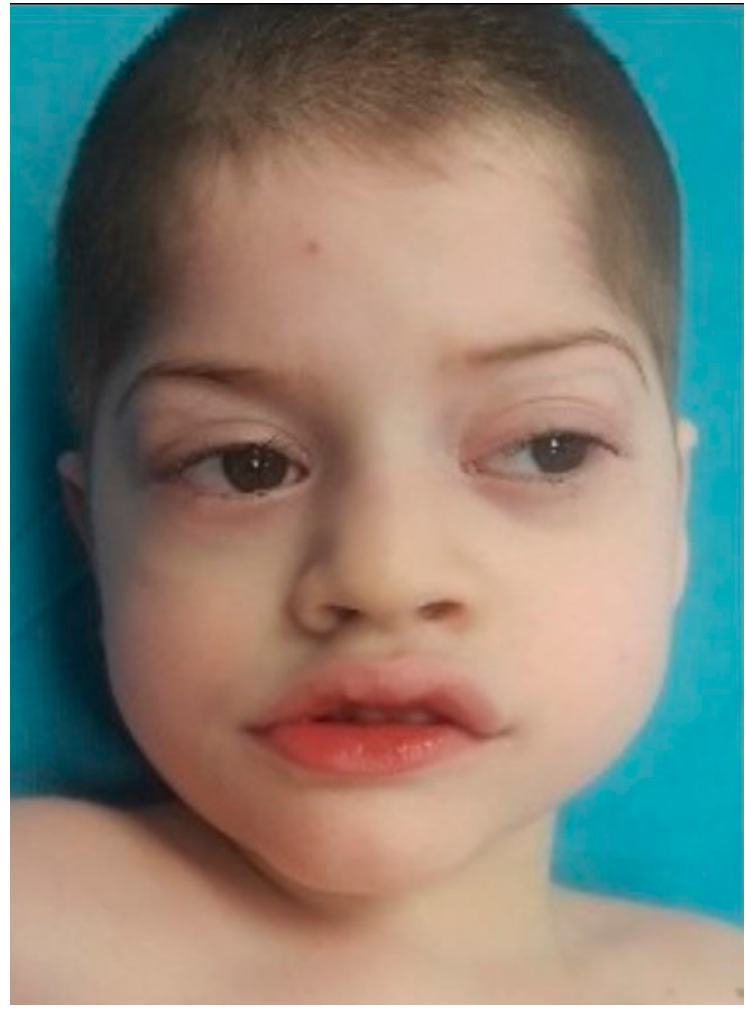
Figure 1. Facial dysmorphism in a 5-year-old boy with Pitt Hopkins syndrome (at the time of first genetic evaluation). Written informed consent from the parents of the patient was obtained for the publication of this image.